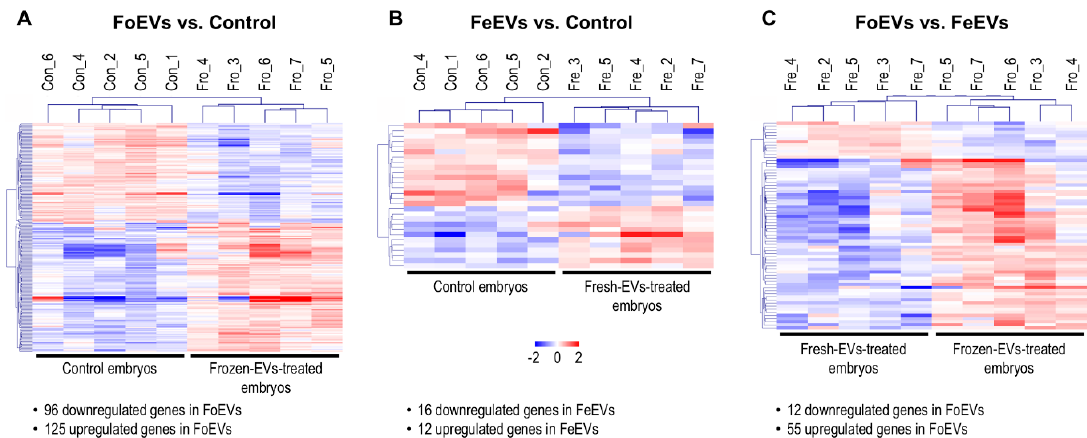
Figure 2. Comparative transcriptome analysis of embryos cultured in vitro under different treatments; ( A ) FoEV-treated and Co embryos; ( B ) FeEV-treated and Co embryos; ( C ) FoEV- and FeEV-treated embryos (Co: control; FoEV: frozen EV; FeEV: fresh EV). Dendrograms representing results of unsupervised hierarchical clustering (HCL) created with Pearson correlation coefficient by MeV. Rows show DEGs while columns represent embryo samples collected under different IVC treatments. Each sample represents a pool of embryos. Mean-centered expression values (log2 counts per million of sample-mean of log2 CPM of all samples) for the samples of the three embryo treatments. Color scale is from -2 (blue, lower than mean) to 2 (red, higher than mean).